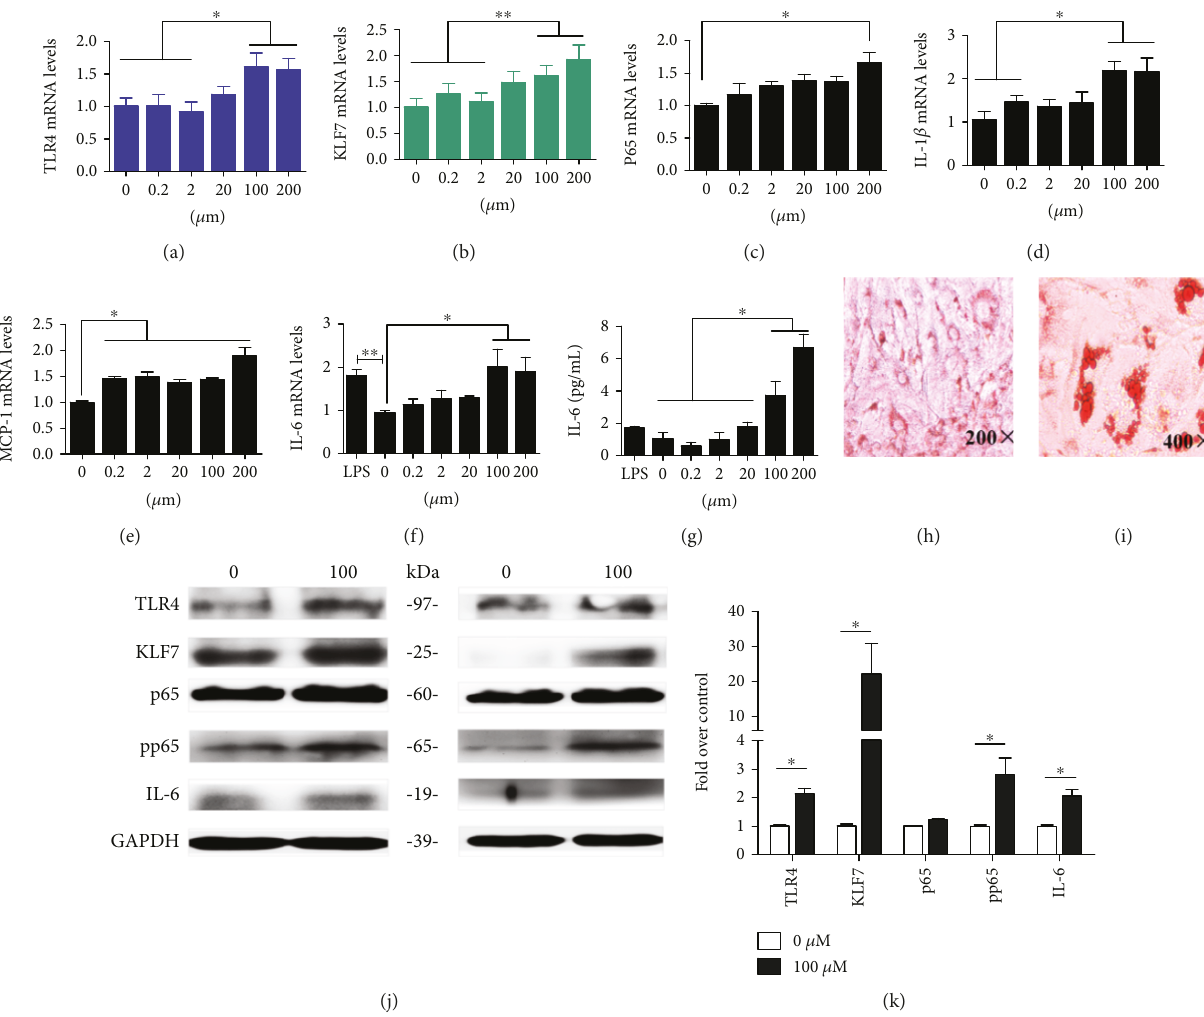
Figure 1: The mRNA expressions of TLR4, KLF7, and in fl ammatory cytokines (a – f) in adipocytes and the IL-6 protein release level (g), which were treated with 0, 0.2, 2, 20, 100, and 200 μ mol/L PA. The protein expression of TLR4, KLF7, and in fl ammatory cytokines in adipocytes was stimulated by 100 μ mol/L PA (j). Di ff erentiation of 3T3-L1 preadipocytes into mature adipocytes, and Oil Red O staining of lipid droplets as viewed under a microscope at (h) 200x and (i) 400x magni fi cation. Grayscale scanning of proteins (k). The data for each group is derived from three replicates of experimental data. One-way ANOVA (a, c – g), Kruskal-Wallis H test (b), T test (k), ∗ P < 0 05 ; the di ff erence was statistically signi fi